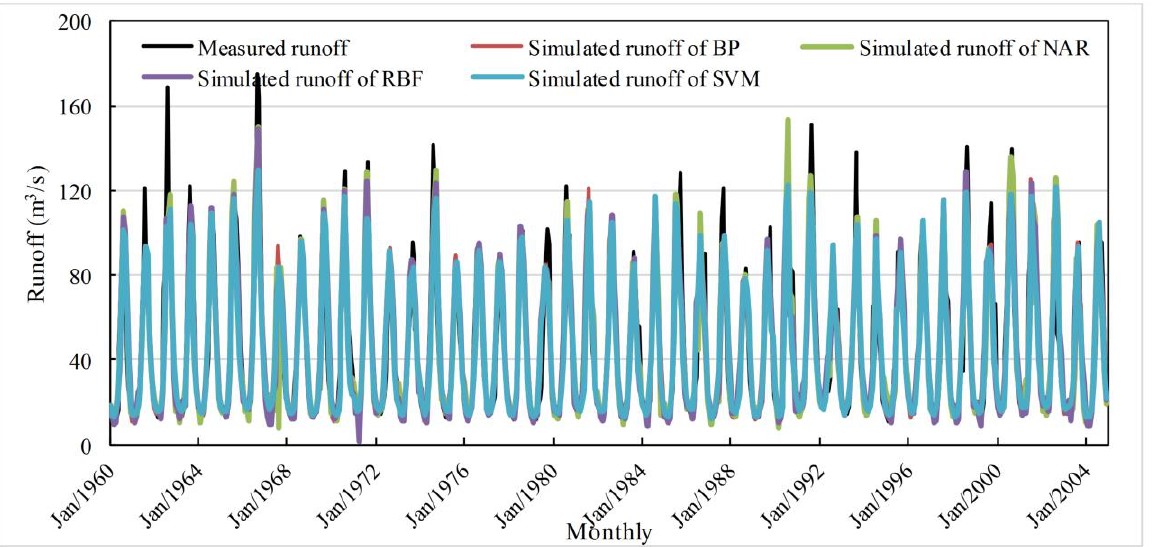
Figure 5. Simulated runoff based on the BP, NAR, RBF and SVM models in the training period. The variance–covariance method and the weight method were adopted to determine the weights for five single models under the evaluation indexes of the simulated accuracy and simulated stability, respectively. Concurrently, the relative weights for the evaluation indexes of the simulated accuracy and simulated stability were obtained by the entropy weight method, as shown in Table